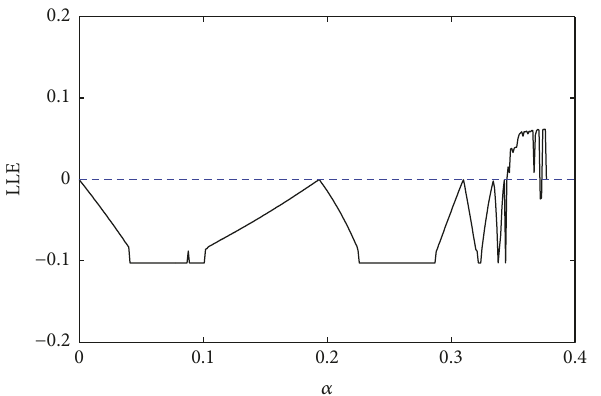
Figure 12: Largest Lyapunov exponent with 𝛼 , 𝛽 = 0.2 and 𝛾 = 0.2 .